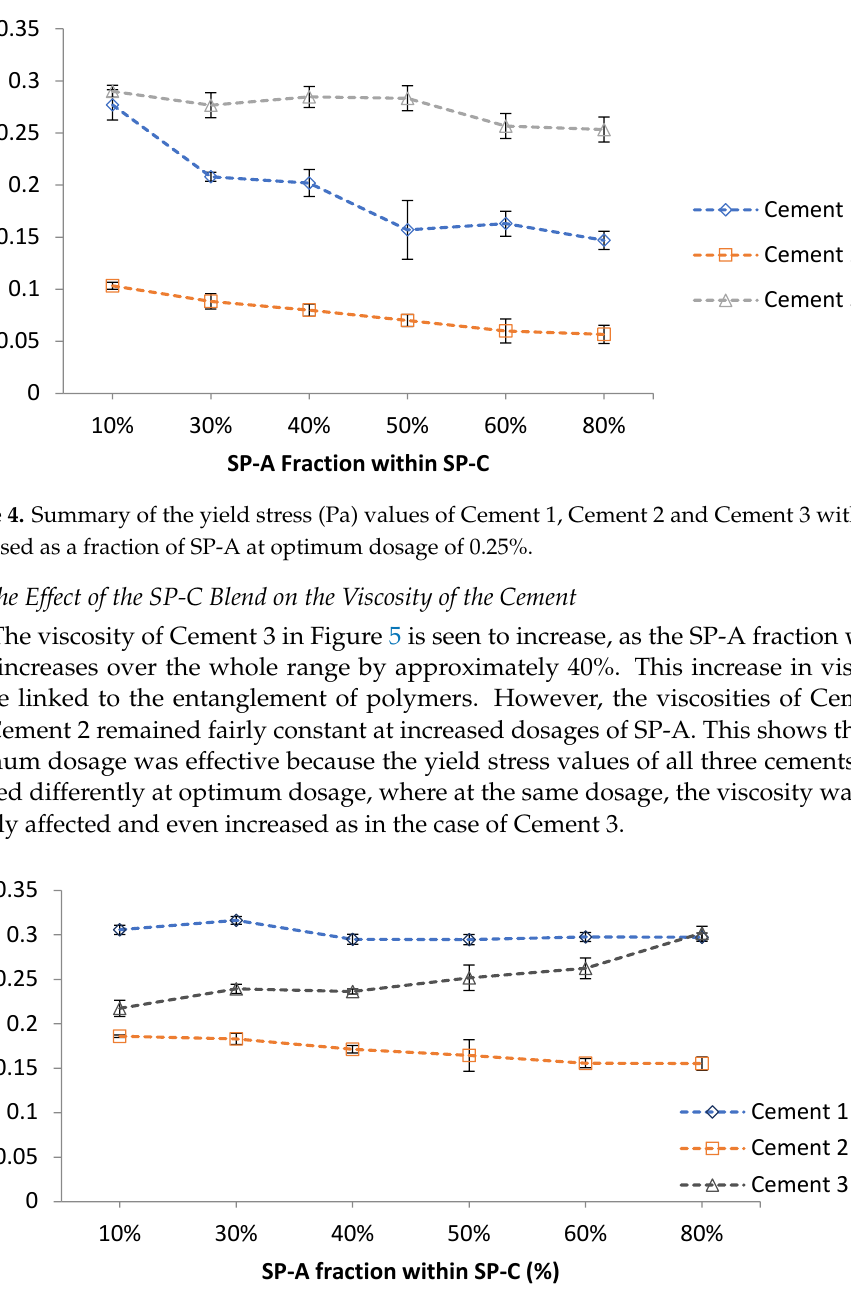
Figure 6. Summary of the adsorption (mg/g cement) of SP- C at 0.25% on Cement 1, Cement 2 and Cement 3. Cement 1, which is coarser, theoretically should adsorb less SP, and with a low sul- phate and alkali equivalent , favors the dissolution of Ca-ions. This allows for the adsorp- tion of SP on the cement without the competitiveness of sulphate ions. Cement 2, which is finer (theoretically should adsorb more SP), released higher sul- phate ions, which was favored by the higher alkali content. This resulted in less SP -A needed in the blend SP-C to reach its hydrophilicity. Cement 3, which is finer and expected to adsorb more SP , was justified by the higher adsorption results. The lack of Ca -ions for sulphate ion reaction favors more SP adsorption to the cement. The slow release of Ca- ions is exacerbated by the low alkali content in the cement.